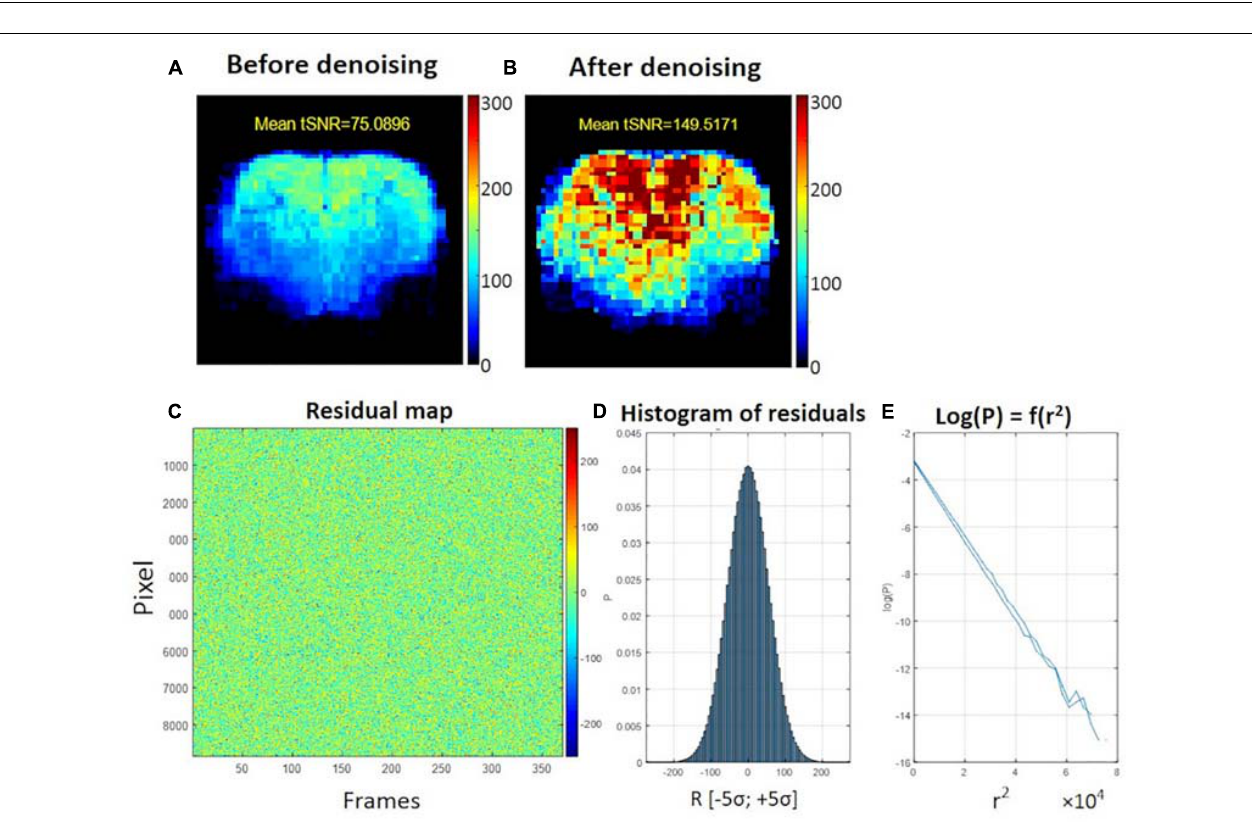
FIGURE 4 | Example of temporal SNR maps, before (A) and after MP-PCA denoising (B) . The mean tSNR over the middle brain slice was improved dramatically from 75 to 146. The SNR profile is typical of a surface coil placed on top of the head, with higher sensitivity in the cortex. (C) Residuals map of all voxels within the brain mask (rows) and time frame (columns). (D) Histogram of residuals. (E) Normality